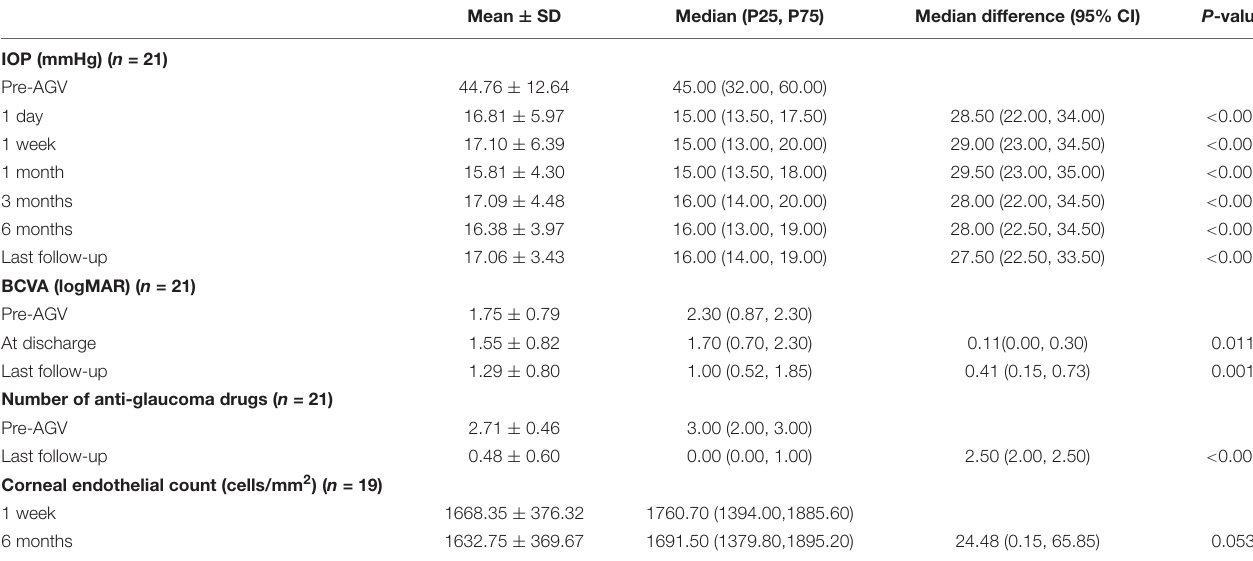
TABLE 2 | Intraocular pressure (IOP), best-corrected visual acuity (BCVA), and number of anti-glaucoma drugs at different time points for patients who underwent pars plana Ahmed valve implantation